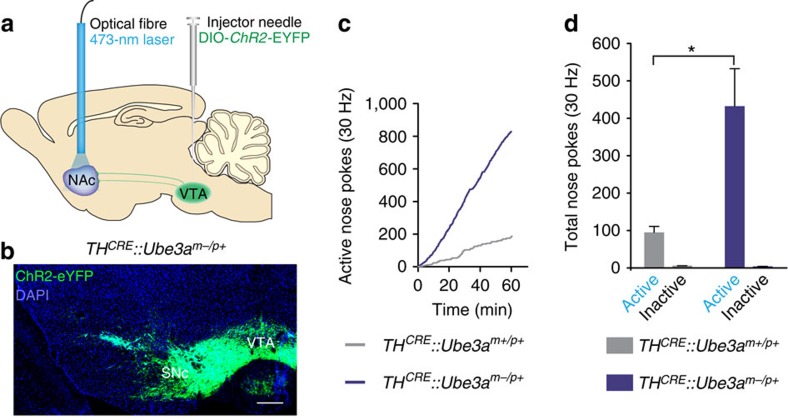
Ube3am−/p+ mice are hyper-motivated to self-stimulate TH-positive VTA-to-NAc terminals.(a) Schematic representation of DIO-ChR2-eYFP viral transduction within the VTA along with NAc chronic fibre placements into THCRE-positive mice. (b) Immunohistochemistry of ChR2-eYFP (green), and DAPI (blue) in a THCRE::Ube3am−/p+ mouse. Scale bar, 500 μm. (c) Cumulative response plots showing nose pokes that trigger a 30 Hz, 473 nm stimulus (active nose pokes) in representative mice. (d) Average number of nose pokes for triggering (active nose pokes) or not triggering (inactive) 30 Hz optical stimulation across a 60-min session. THCRE::Ube3am−/p+ mice were significantly more motivated to trigger optical stimulation than THCRE::Ube3am+/p+ mice (n=7/group, one-way ANOVA, *P<0.05). All bars represent the mean±s.e.m.